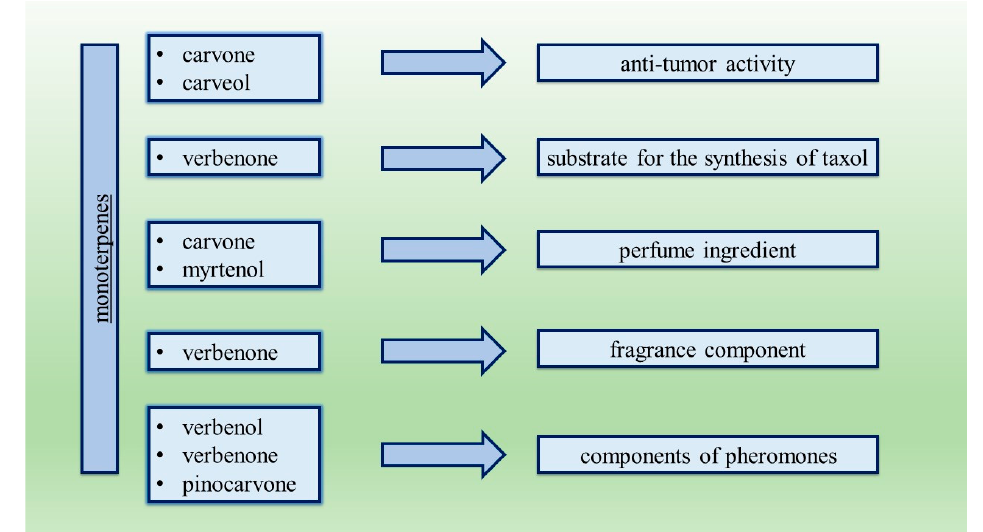
Figure 1. Monoterpenes obtained during oxidation of α -pinene and their applications.